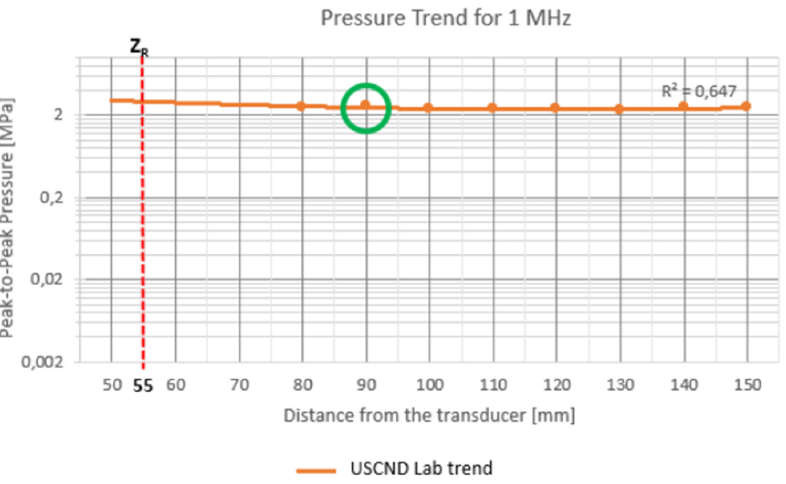
is at a distance of 120 mm from the translator.